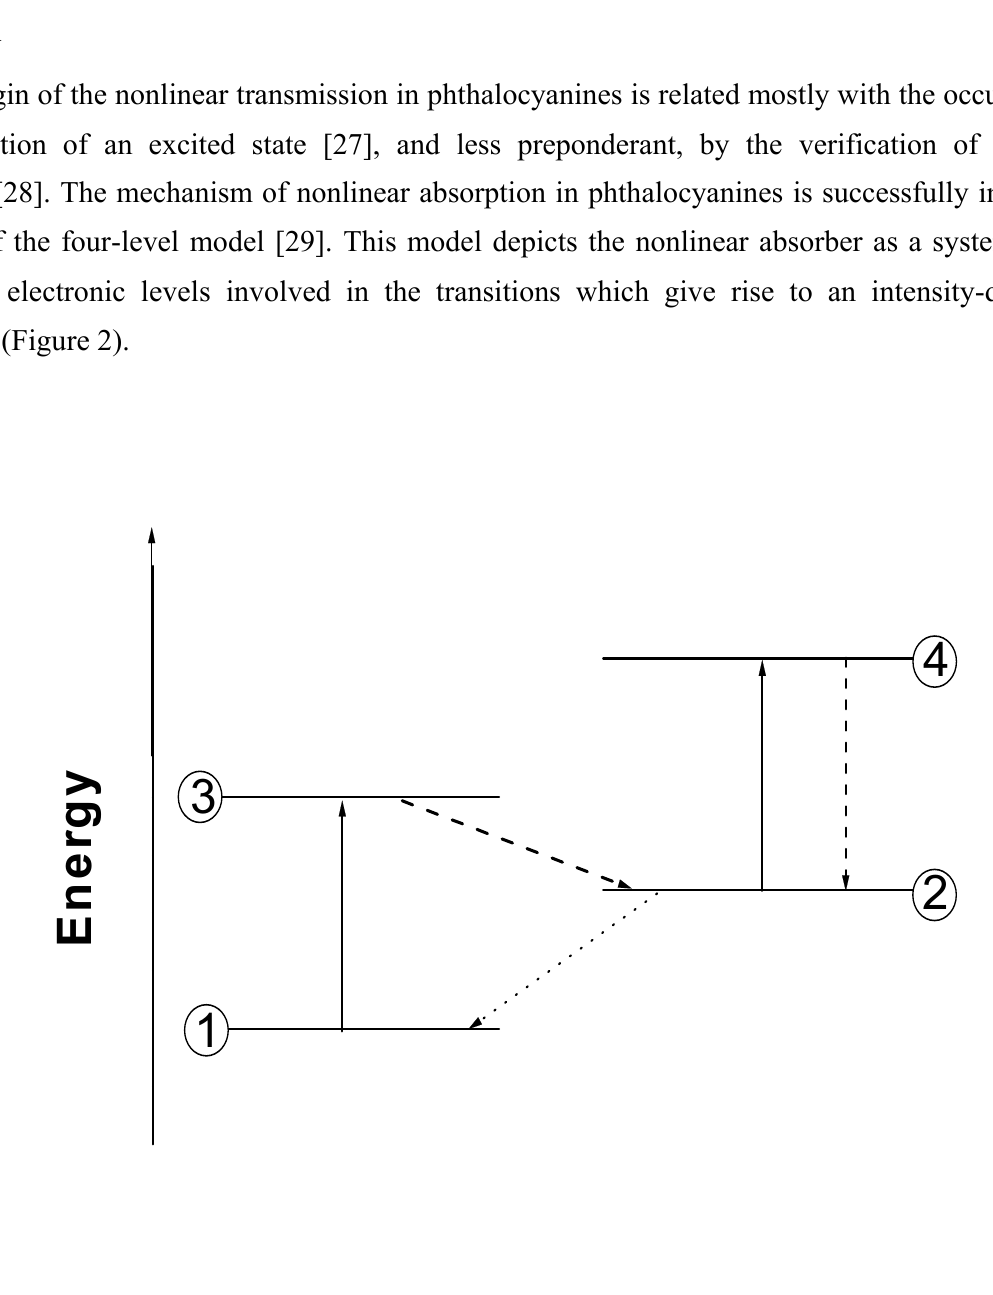
Figure 2. Energy diagram of a four-level system. Full lines indicate absorption from singlet ground [1 → 3] and triplet excited states [2 → 4]; dashed lines represent intersystem crossing [3 → 2] and excited state fluorescence [4 → 2]; dotted line indicates phosphorescence [2 →